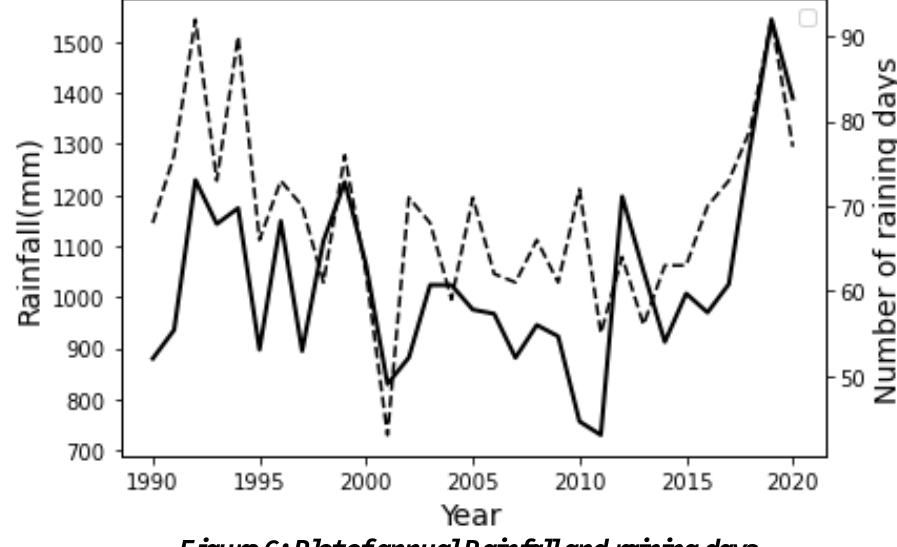
Figure 6: Plot of annual Rainfall and raining